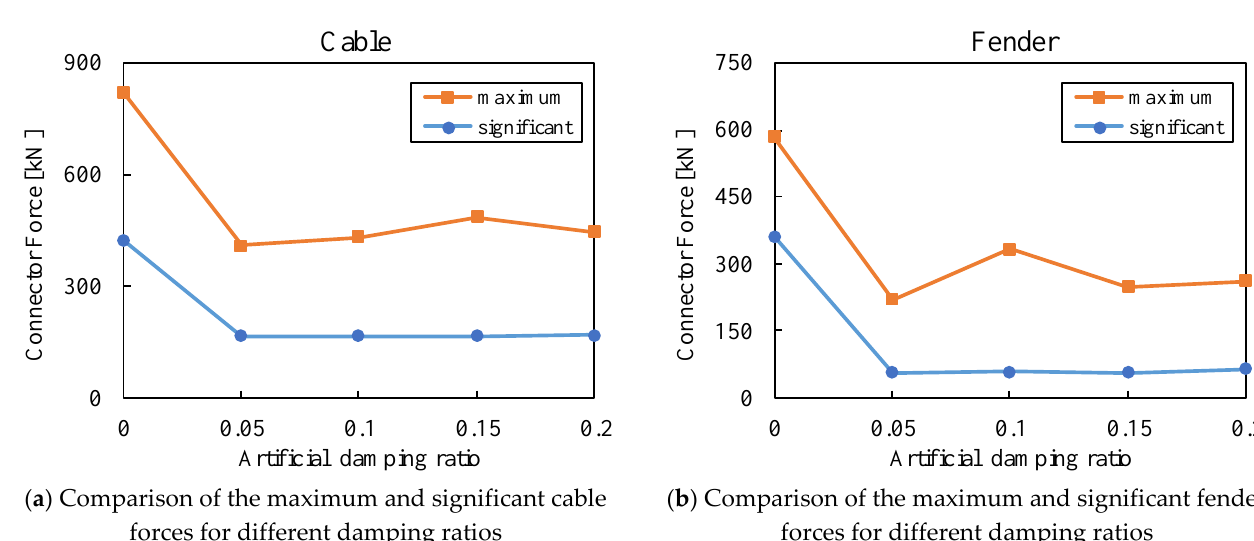
Figure 23. T he statistical results of connector load for RMFC model ( T p = 3.7 s). Figure 23. The statistical results of connector load for RMFC model ( T